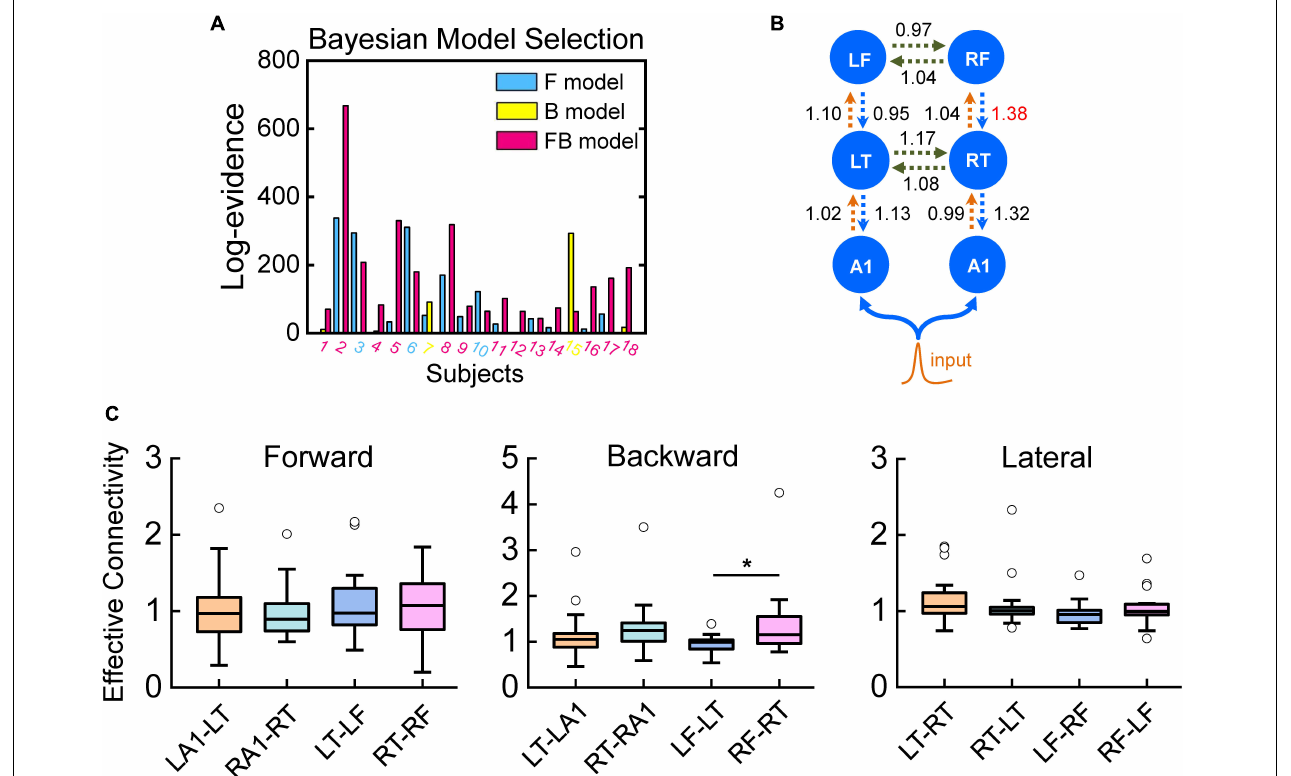
FIGURE 5 | Quantitative effective connectivity. Bayesian model selection among DCMs for the three models, F, B, and FB, expressed relative to a DCM in which no connections were allowed to change (null model). The graphs show the free energy approximation to the log-evidence. (A) Log-evidence for models F, B, and FB for each amateur musician (relative to the null model). The diamond attributed to each subject identifies the best model on the basis of the subject’s highest log-evidence. Log-evidence at the group level, i.e., pooled over subjects, for the three models. (B) Effective connectivity of the FB model. (C) In the bar plots, significant difference on the backward connection from the frontal lobe to the temporal lobe of the right hemisphere compared to the backward connection from frontal lobe to temporal lobe of the left hemisphere and no difference between the two hemispheres on the forward and lateral